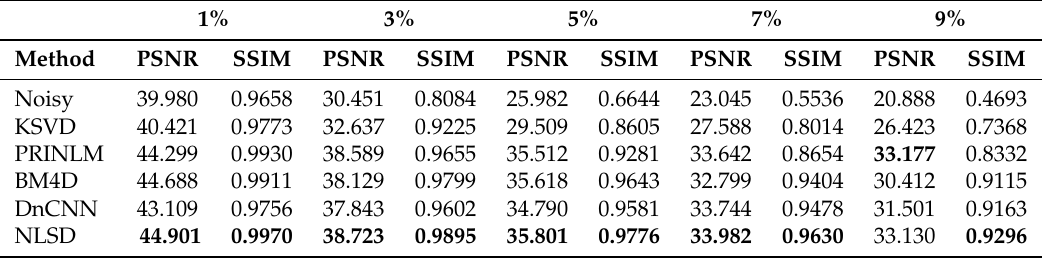
Table 1. Comparison of the different methods evaluated on the T1w synthetic noise-free MR image corrupted with different levels of Rician noise. Bold highlights indicate the best results.